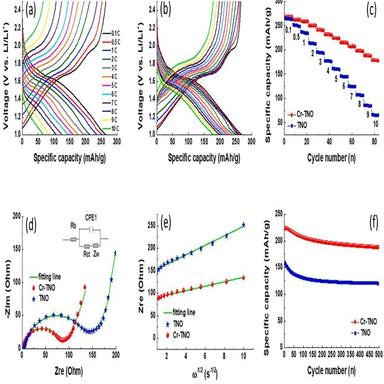
Energy storage performance of as-prepared TNO. (a, b) Charge/discharge profiles of (a) TNO and (b) Cr-TNO. (c) Rate capabilities of TNO and Cr-TNO, measured at C-rates between 0.1 and 10C. (d) Nyquist plots of the pristine and doped TNO (inset: equivalent circuit model used to fit the EIS data). (e) Plots of real parts of the complex impedance versus ω–1/2. (f) Cycling performance of TNO and Cr-TNO half cells.